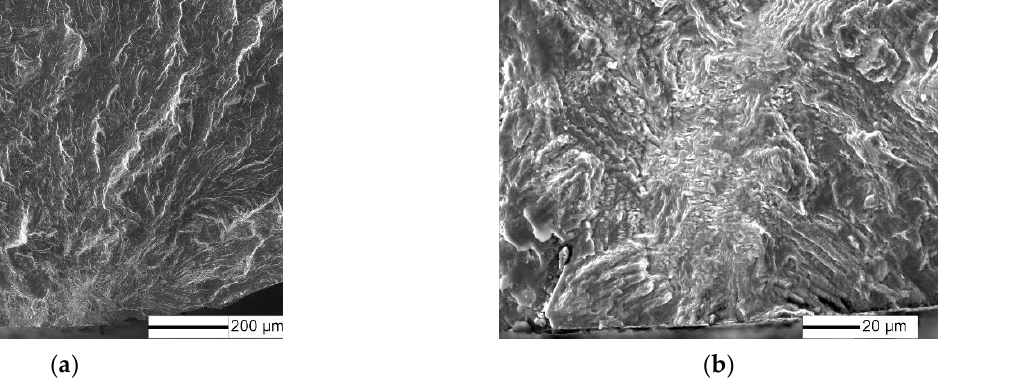
Figure 5. Fracture surface for 2.5% predamage specimens at σ = 450 MPa and N = 1.8 × 10 6 cycles: ( a ) macroscopic morphology, and ( b ) crack initiation morphology.